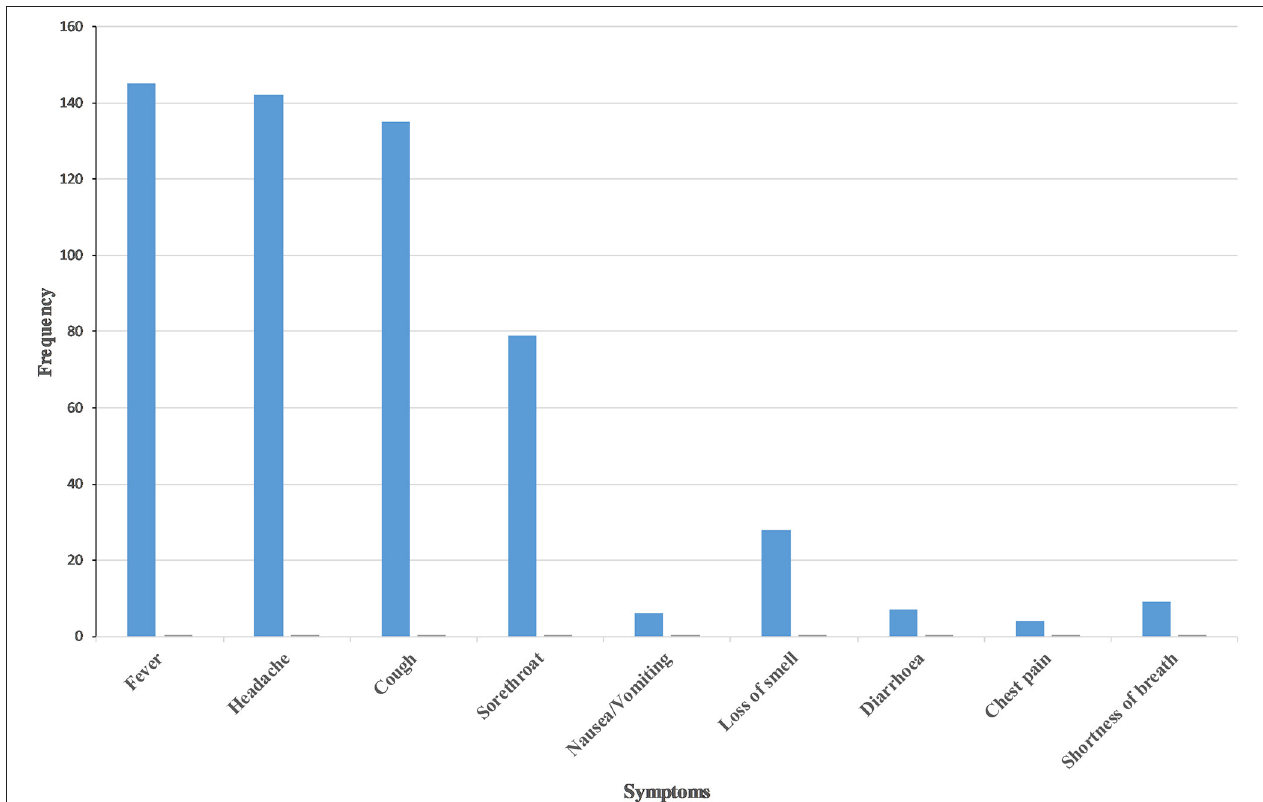
FIGURE 3 | Clinical features of COVID-19 in Samtse District,